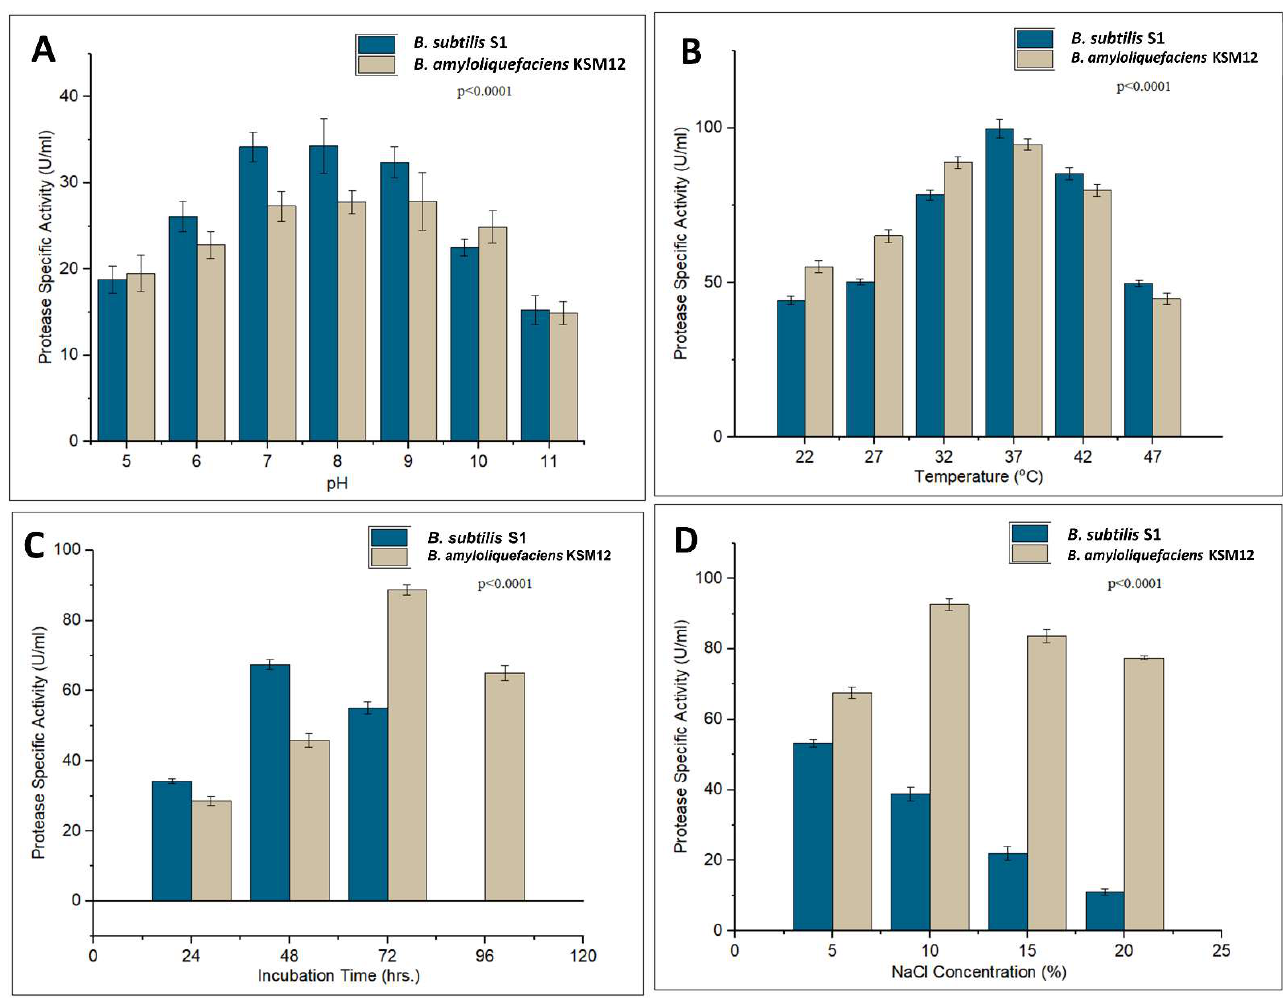
Figure 4. Optimization for protease production by B. subtilis S1 and B. amyloliquefaciens KSM12. ( A ) pH optimization (F = 20.03, p < 0.0001), ( B ) temperature optimization (F = 237.6, p < 0.0001), ( C ) incubation time optimization (F = 338.72, p < 0.0001), and ( D ) NaCl optimization (F = 73.75, p < 0.0001).